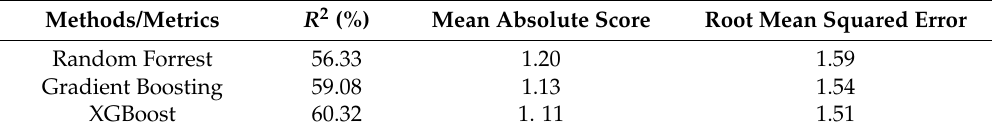
Table 4. Model Performance comparison between methods.